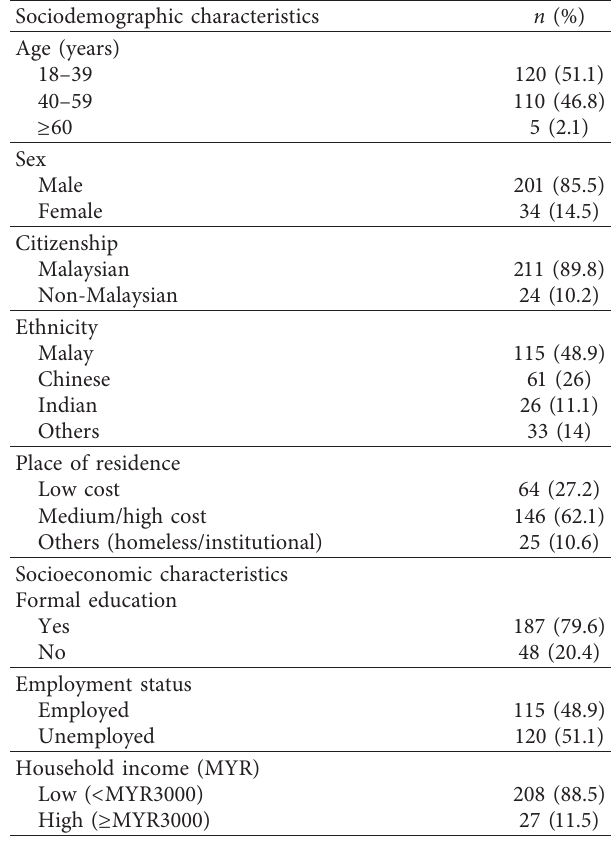
Table 1: Sociodemographic and socioeconomic characteristics of patients with TB-HIV coinfection (total patients, n �